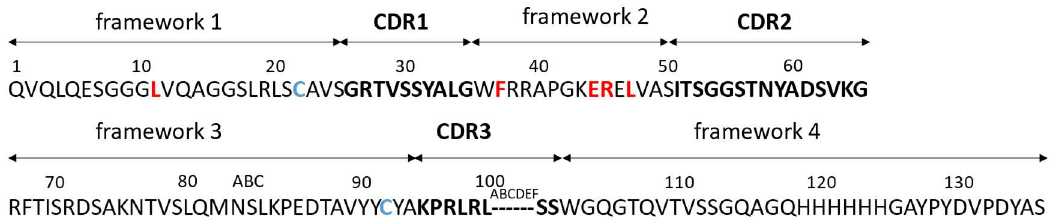
Figure 5. The amino acid sequence of VHH_19 displays the three CDRs (black, bold) and four frameworks. The residues were numbered according to the Kabat numbering scheme. The four hallmark amino acid changes at positions 37, 44, 45, and 47 within framework 2 are marked in red. Moreover, the sequence showed the two conserved Cys residues at positions 22 and 92 (blue). The His- and HA-tags were located at the C-terminus.